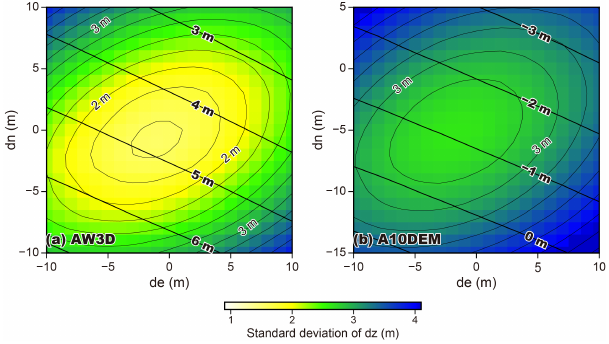
Figure 3. Distribution of elevation bias (dz, thick contour lines) and its standard deviation (color shadings with thin contour lines) of (a) AW3D and (b) A10DEM against the UAV DEM on 23 Octo- ber, which are calculated over the off-debris area (Fig. 2a). ALOS DEMs are shifted at 1m interval to both directions of west to east (de, horizontal axis) and of south to north (dn, vertical axis), and then mean elevations for 5m cells (corresponding to the ALOS DEMs) are calculated from the UAV DEM, which is resampled to 5m from the original 1m resolution. Table 2. Accuracy evaluation of digital elevation models over off- debris area (Figs. 3 and 4). Average and standard deviations of el- evation difference (unit is meter) are listed on the lower left and upper right in the table, respectively. Subtraction is performed as re- cent DEM (lower in the column or righter in the line) is subtracted by previous one. Cell size for the comparison with AW3D is 5m while the others are 1m. Comparison with dGPS data is shown in Fig.